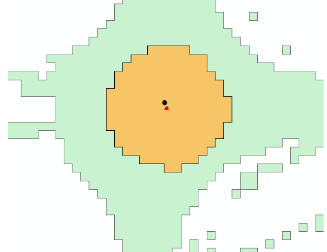
Figure 6. Distance measurement. The black circle point is the centre of the extracted roundabout, and the red triangle one is the centre of the detected hole.